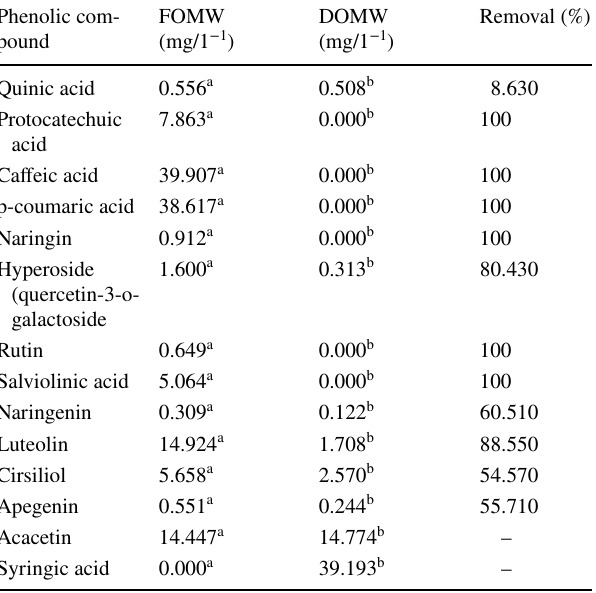
Table 2 Phenolic composition of FOMW and DOMW; reduction of single phenolic components was represented in removal percent